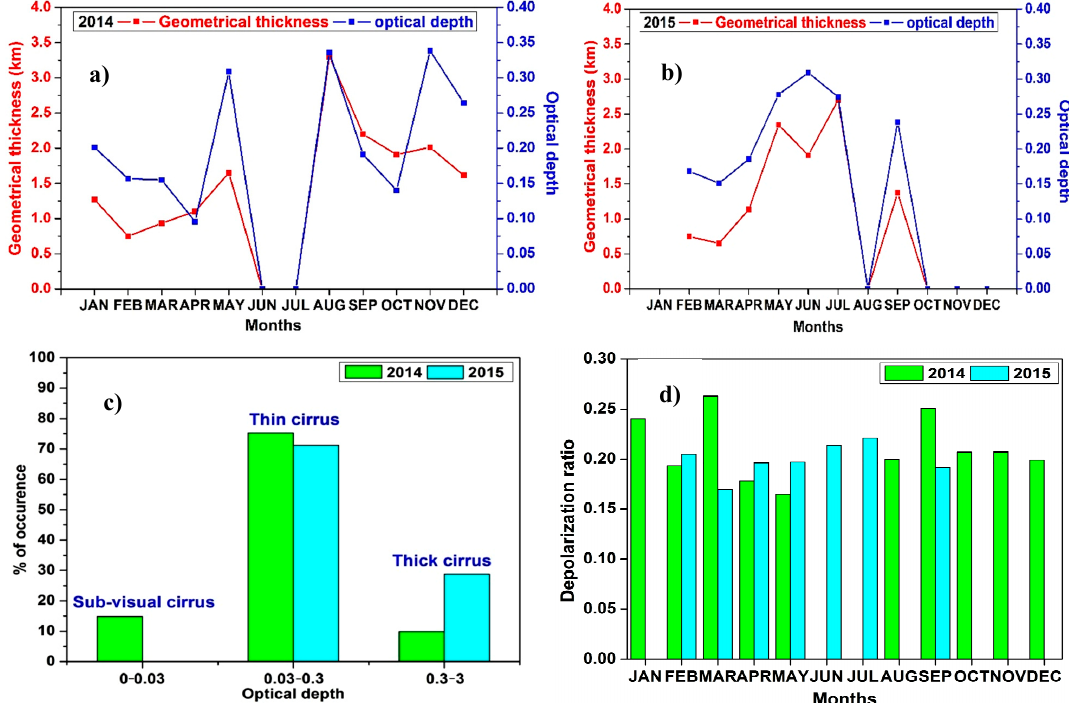
Figure 9. ( a , b ) shows the monthly variations of optical depth vs. geometrical thickness of cirrus clouds; ( c ) Occurrence frequency of cirrus clouds of different types; and ( d ) Monthly variations of the depolarization ratio of cirrus clouds during 2014 and 2015.